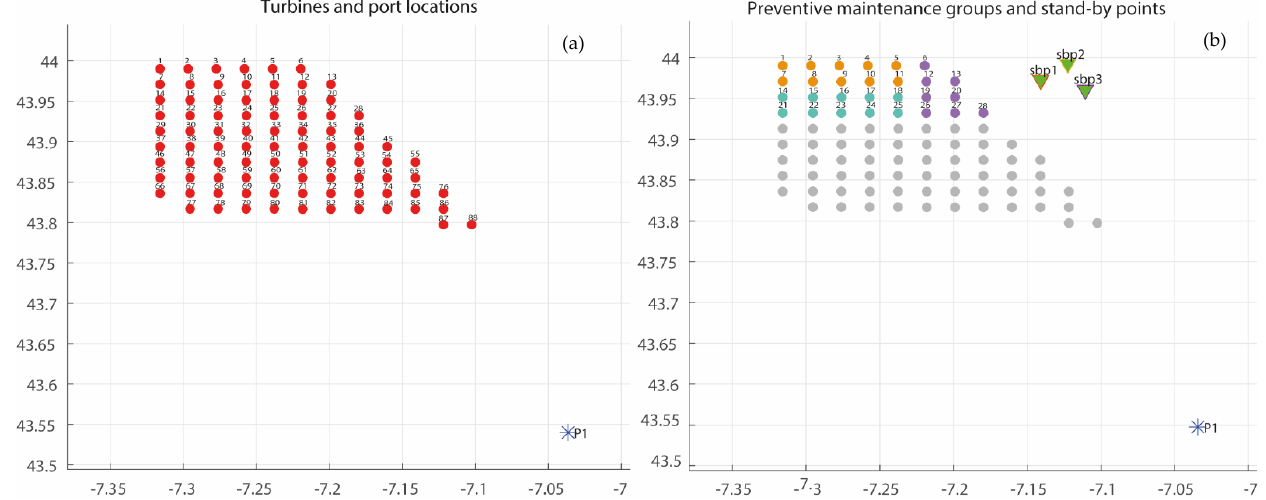
Figure 2. ( a ) Ribadeo floating wind farm layout ( b ) maintenance planning and possible offshore base locations. The asterisk symbol represents the port location. Table 2. Vessel’s characteristics and cost information.